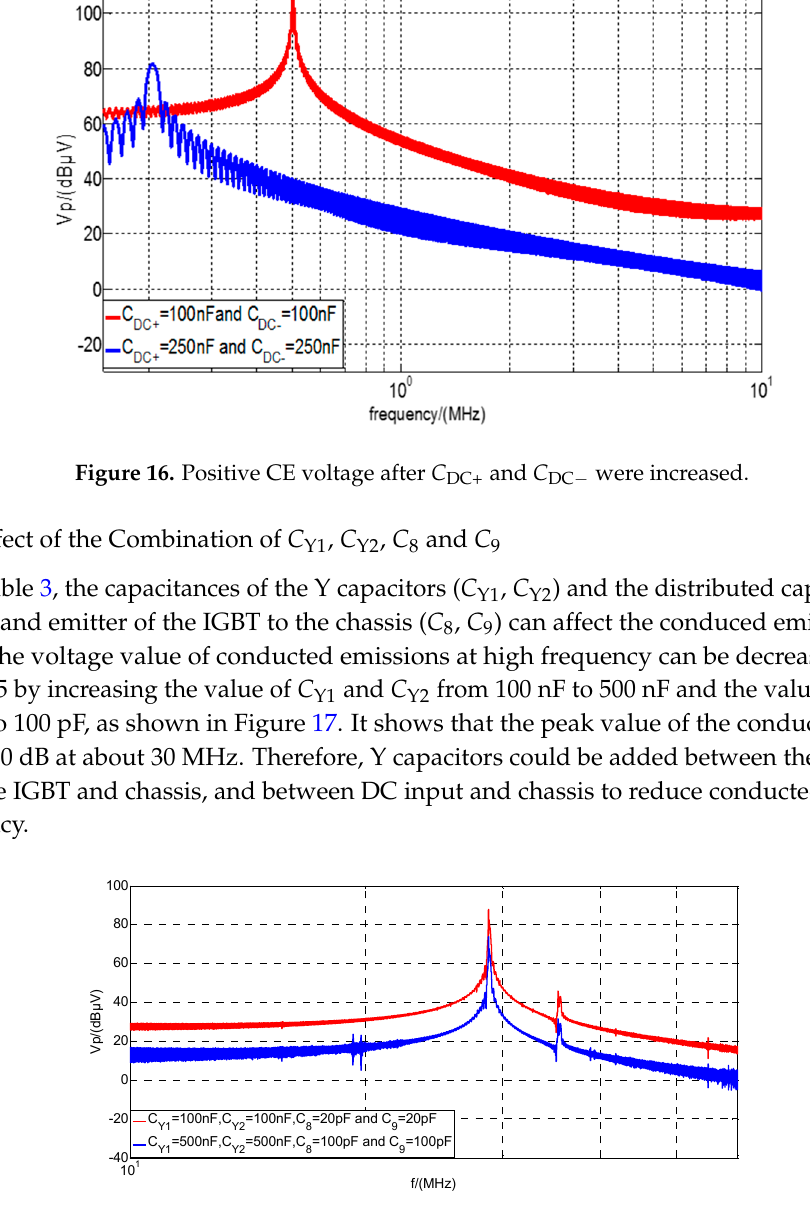
13 of 17 Figure 15. Positive CE voltage after L DC bus bar+ , L DC bus bar − , L Y1 and L Y2 were increased. 4.2.4. The Effect of C DC+ and C DC − From Table 3, the distributed capacitances from DC cables ( C DC+ , C DC − ) can affect the conducted emissions. Changing the value of C DC+ and C DC − can mitigate the resonance at 500 kHz and reduce the conducted emission at low frequency. The voltage value of conducted emission at 500 kHz can be decreased by about 25 dB by increasing the value of C DC+ and C DC − from 100 nF to 250 nF to comply with the limit level-3 of CISPR25, as shown in Figure 16. It suggests that filtering and